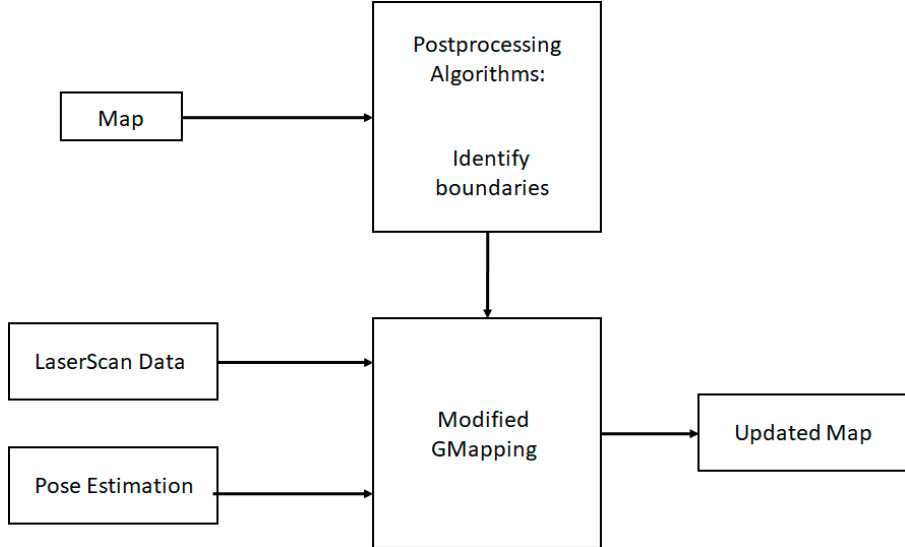
Figure 23. Proposed Postprocessing Algorithm.